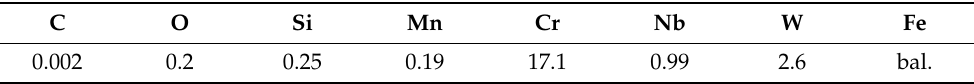
Table 1. Chemical composition in wt. % of the manufactured model alloy